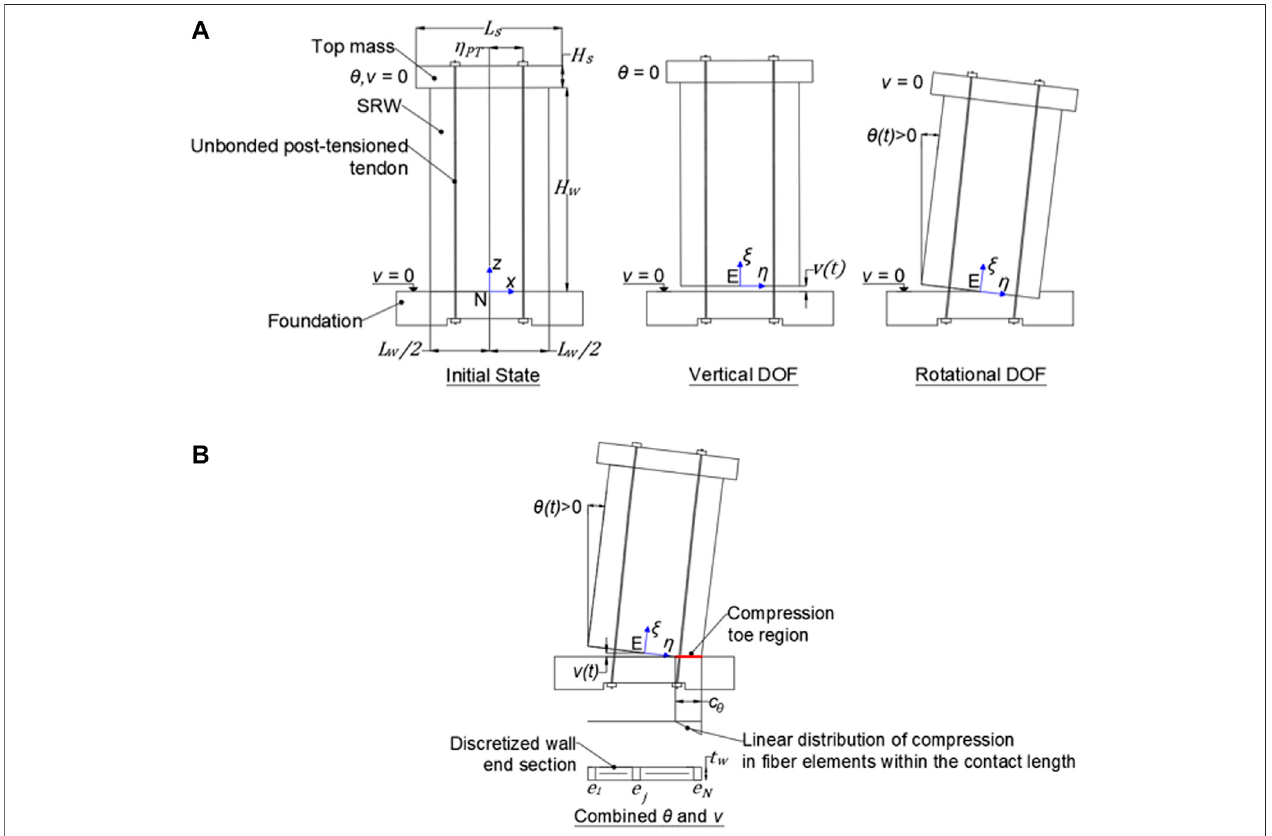
FIGURE 6 | (A) A single rocking wall (SRW) modeled by the generalized dynamic analysis approach (GDAA); (B) Combined rotational θ and vertical v motions of a SRW as per the GDAA.